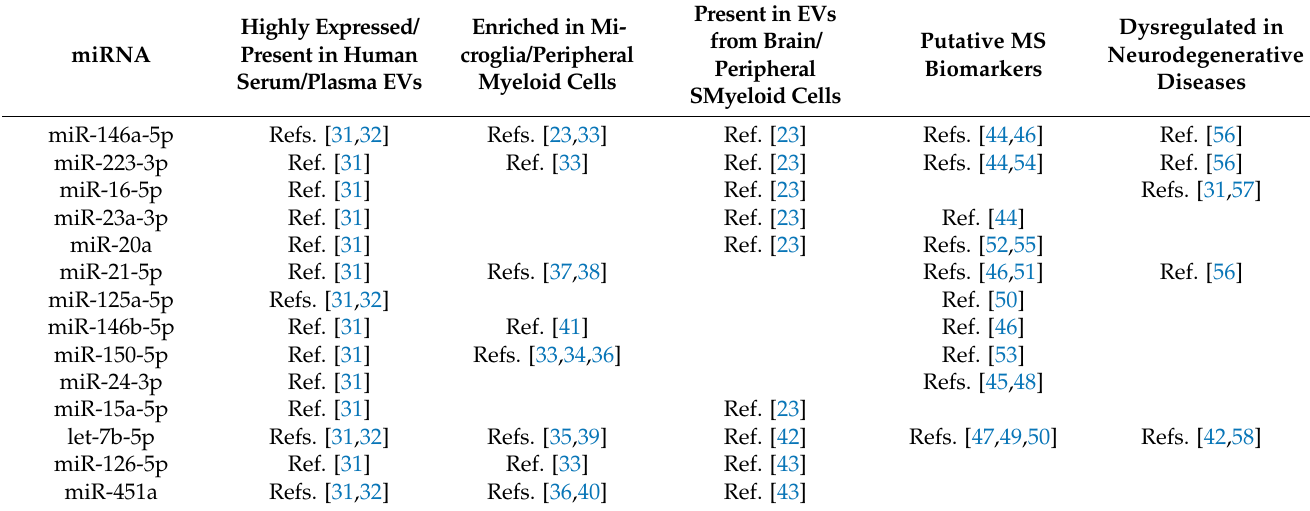
Table 2. Characteristics of selected miRNAs targeting synaptic